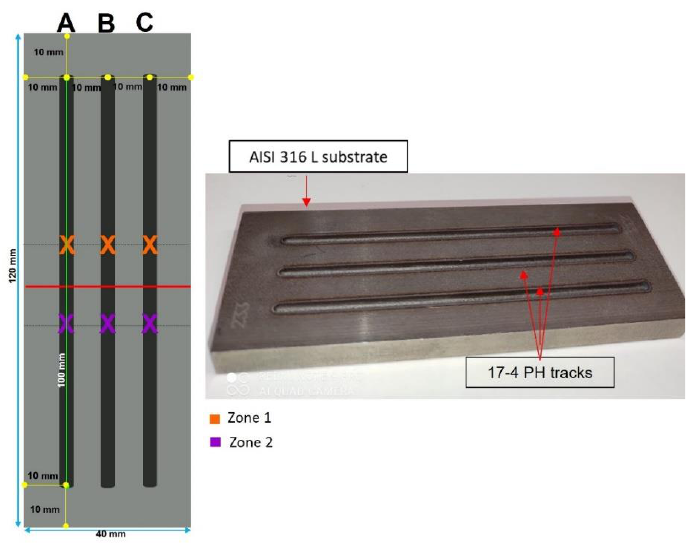
Figure 3. Example of single-track DED depositions: sampling positions along the tracks are highlighted with a “X”.